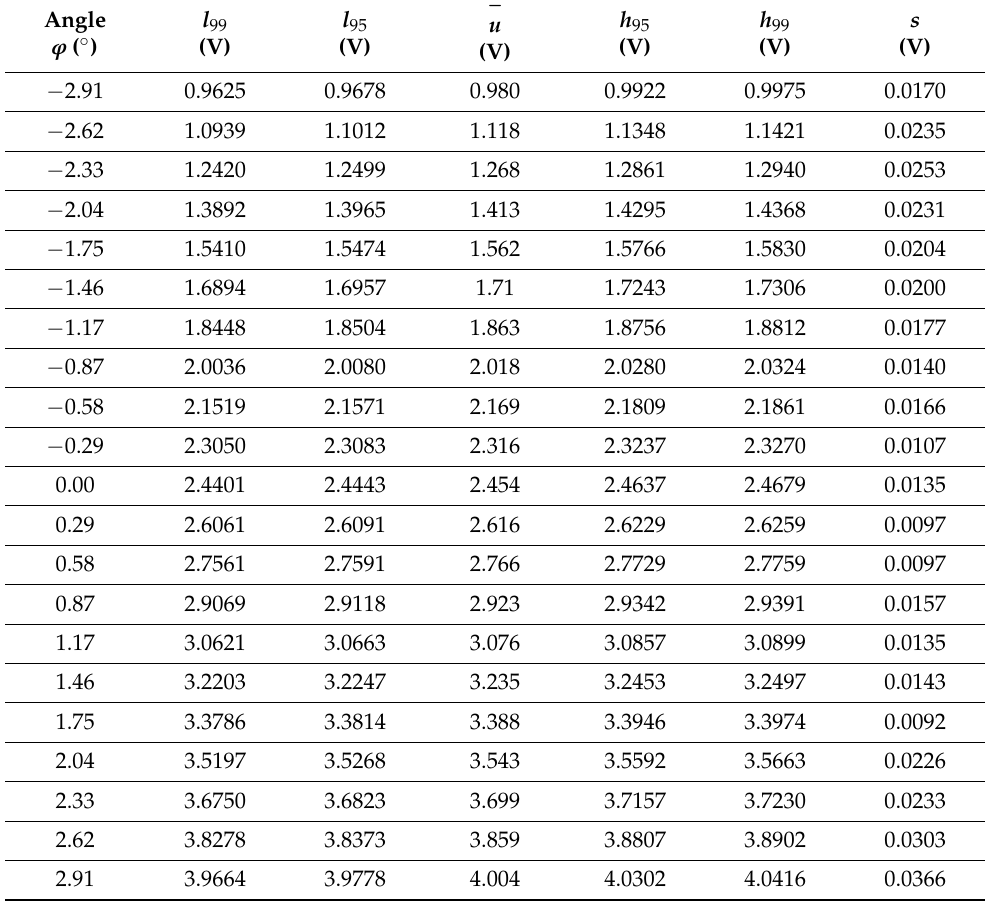
Table 2. Totals of 99% and 95% confidence intervals, Student’s probability